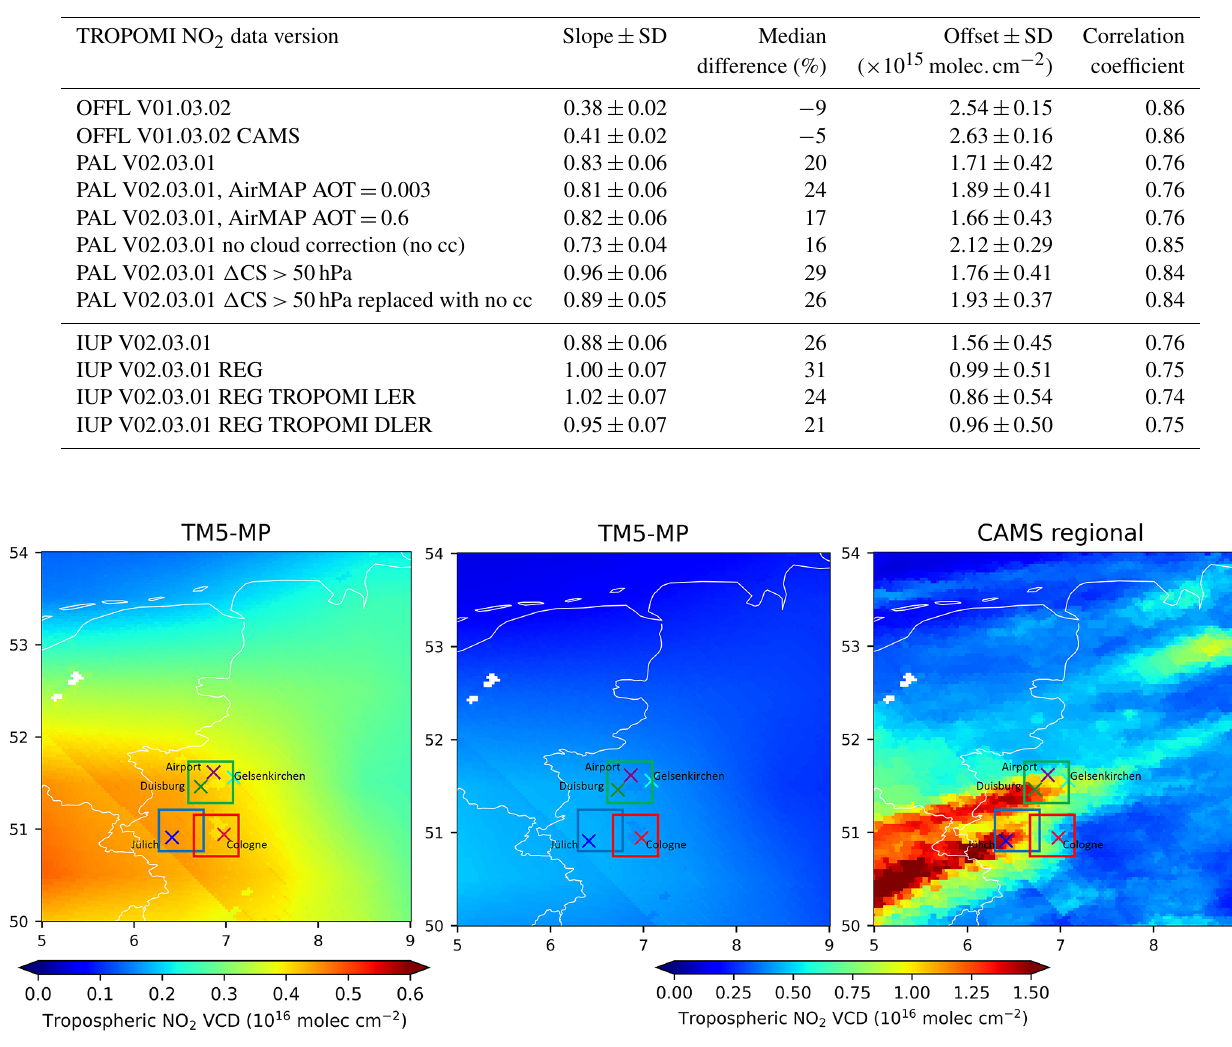
Figure A1. Tropospheric NO 2 VCD of the TM5-MP (1 ◦ × 1 ◦ ) and the CAMS regional (0.1 ◦ × 0.1 ◦ ) analysis for the campaign region on 17 September 2020, interpolated to TROPOMI pixels and oversampled to a 0.03 ◦ × 0.03 ◦